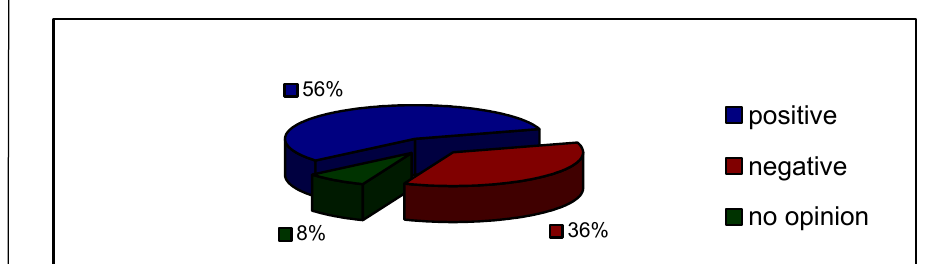
Figure 2 – Assessment of fulfilled expectations from subordinates concerning the decisions made